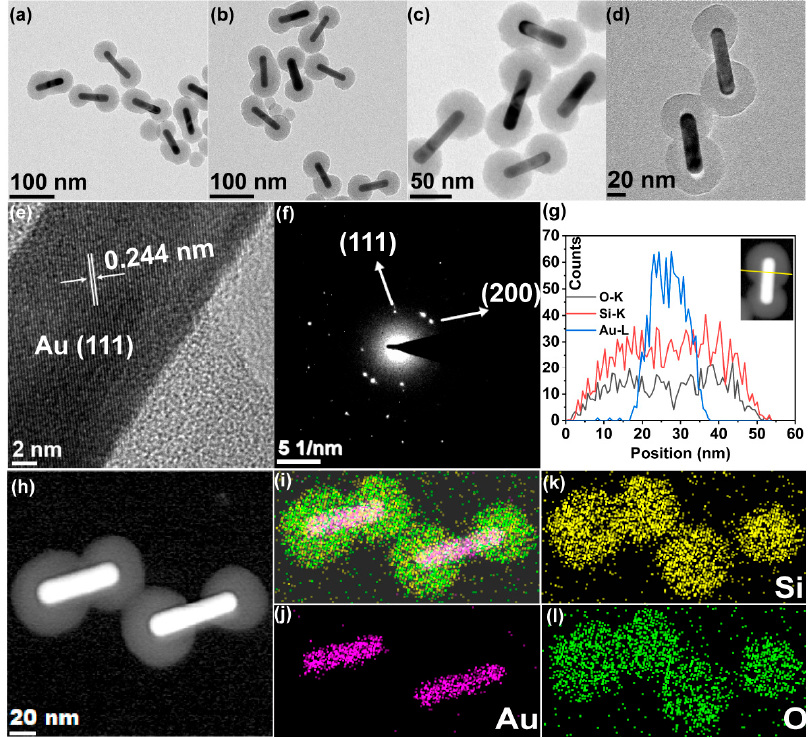
Figure 4. Typical TEM images of silica-coated GNRs prepared under the guidance of ML predic- tions. The process parameters are ( a ) 1 mM CTAB and 300 μ L TEOS single injection volume, ( b ) 1 mM CTAB and 250 μ L TEOS single injection volume, ( c ) 1 mM CTAB and 200 μ L TEOS single injection volume, and ( d ) 1 mM CTAB and 150 μ L TEOS single injection volume, respectively. ( e ) High-resolution TEM images of silica-coated GNRs. ( f ) Selected area electron diffraction pattern of silica-coated GNRs. ( g ) EDX line scanning profiles analyzed across the end spherical region as viewed along the line in the inset of the HAADF-STEM image. ( h ) STEM images before EDX mapping of the silica-coated GNRs. ( i ) The corresponding elemental mixed mapping images of elements Au ( j ), Si ( k ), and O ( l ).